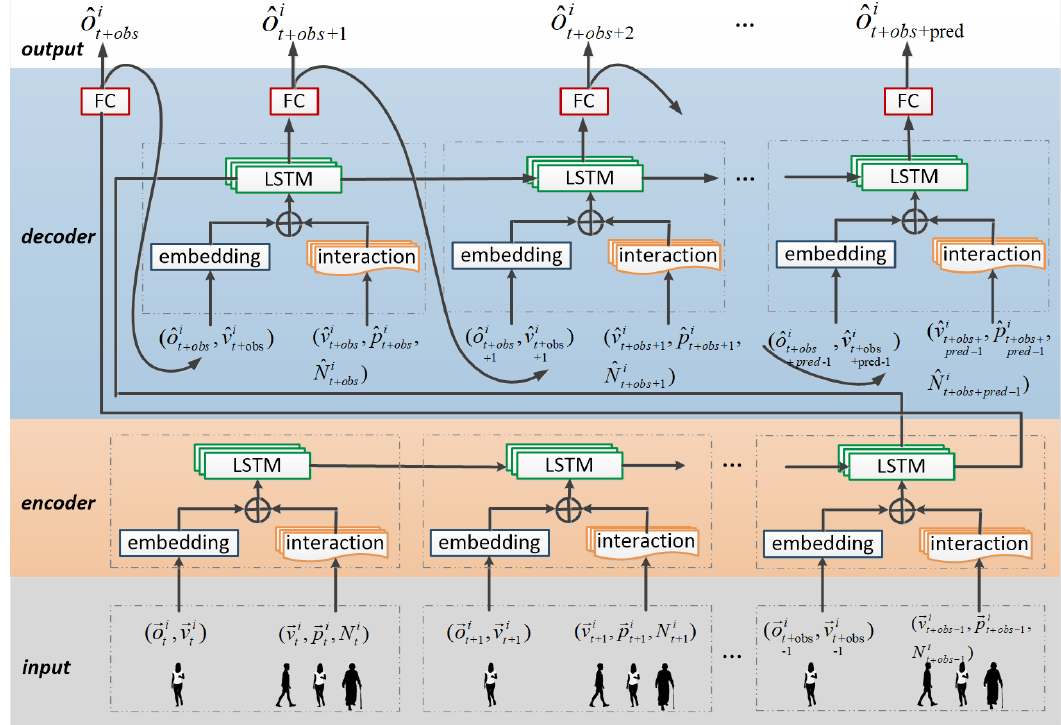
Figure 4. Network structure. It includes an encoder and a decoder, shown in orange and blue, respectively. The encoder encodes the observed trajectory, and the decoder performs the prediction. There is a subnetwork “interaction”, which encodes the agent–neighbor